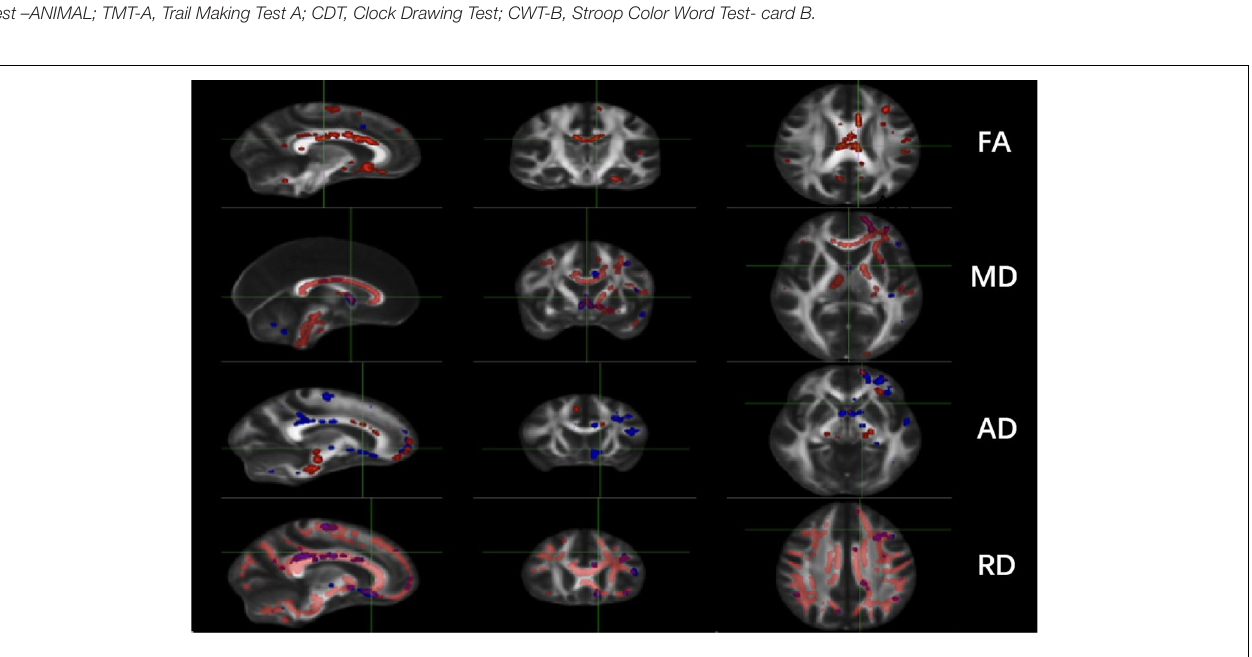
cognitive scores by Pearson correlation analysis. The